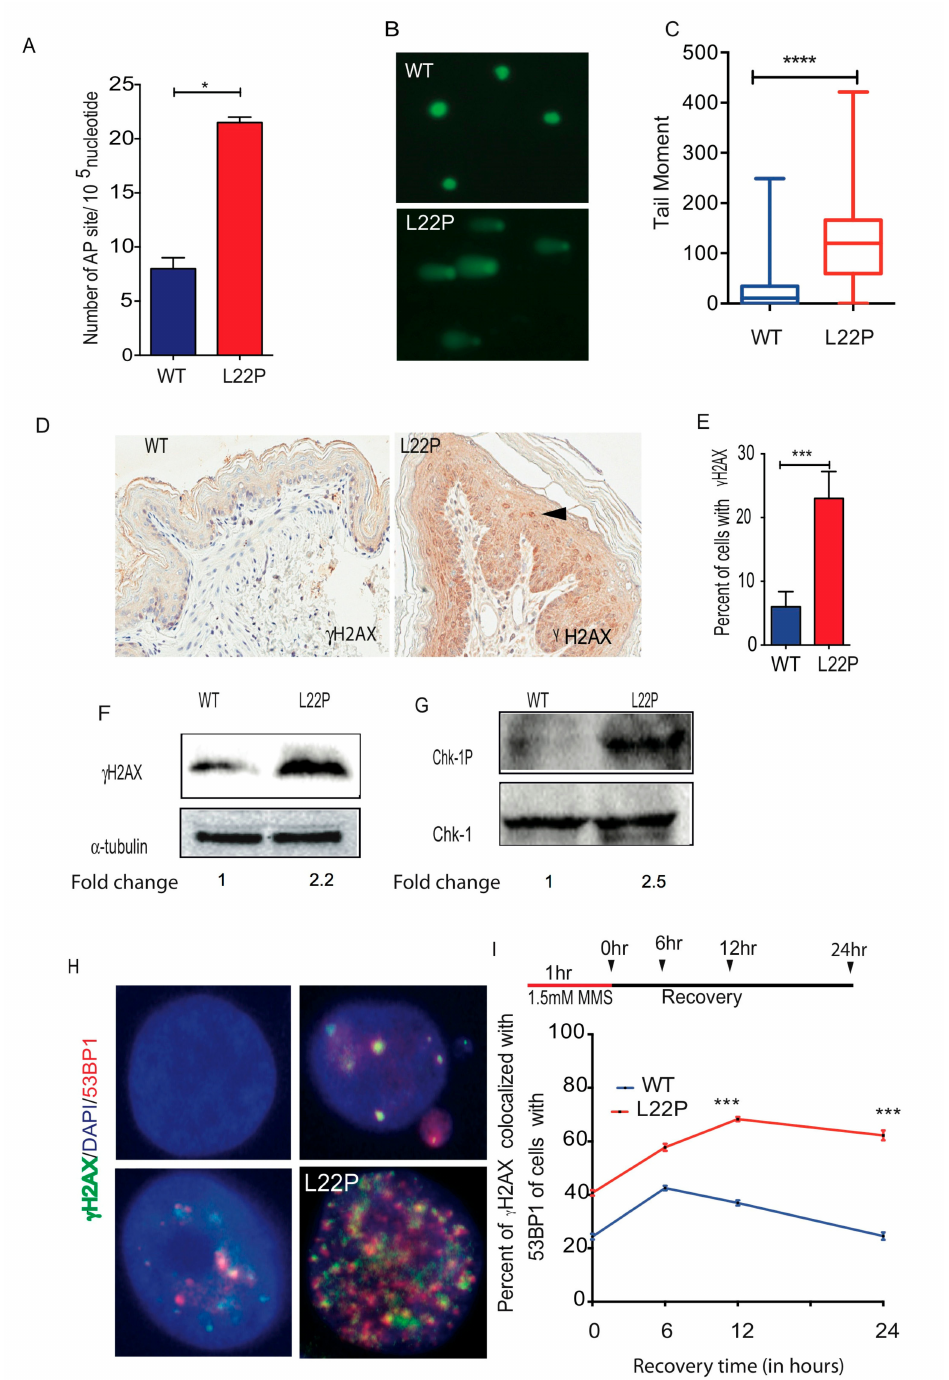
Figure 3. L22P mice accumulate base excision repair (BER) intermediates and exhibit double strand breaks (DSBs). ( A ) Number of apurinic / apyrimidinic (AP) sites / 10 5 nucleotides from DNA extracted from wild type (WT) and L22P mice stomach tissues; ( B ) Representative image of spontaneous single strand breaks (SSBs) from Alkali comet assay on WT and L22P mouse embryonic fibroblasts (MEFs) cells, All image captured with 63 × objective of Zeiss fluorescence microscope (Zeiss, San Diego, CA, USA); ( C ) Measured tail moment for measuring spontaneous SSBs in WT and L22P MEFs cells and data analysis carried out using Student’s t test; ( D ) Immunohistochemical staining with phosphorylated H2AX ( γ H2AX) antibody of stomach tissue sectioned from WT and L22P mice; Image shows 5 × magnification and were captured using Scanscope (Leica Biosystem, Vista, CA, USA); ( E ) Percent of γ H2AX-positive cells in the WT ( n = 2000) and L22P ( n = 2078) mouse stomachs. Data were analyzed using Mann–Whitney